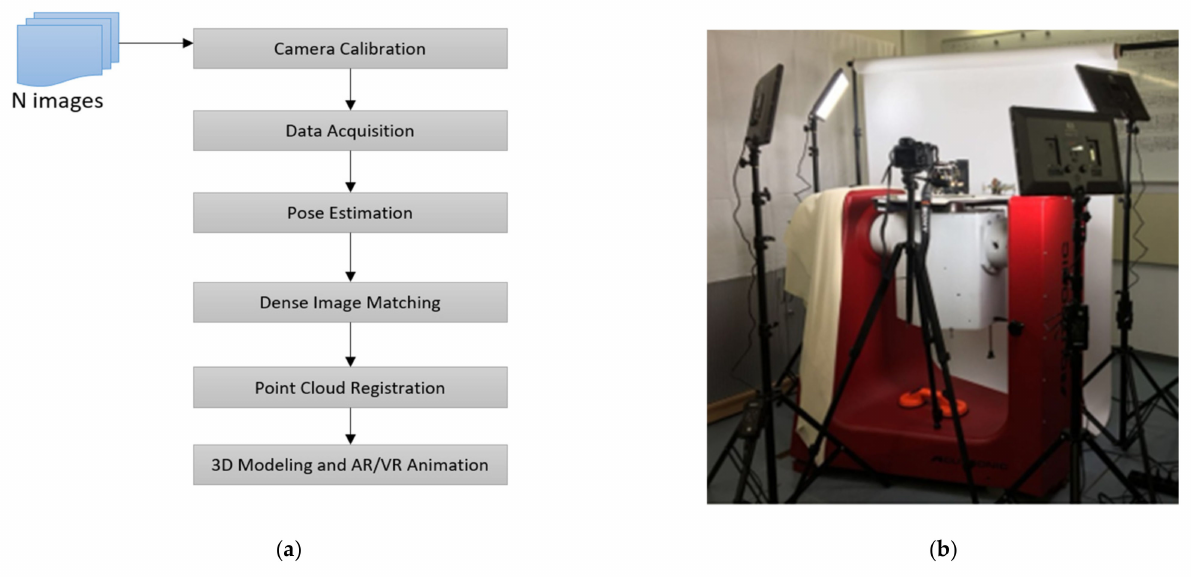
Figure 18. Data acquisition in the Gyrolog project: ( a ) workflow of CV/photogrammetry; and ( b ) Gyrolog Lab facility used for photo collections.